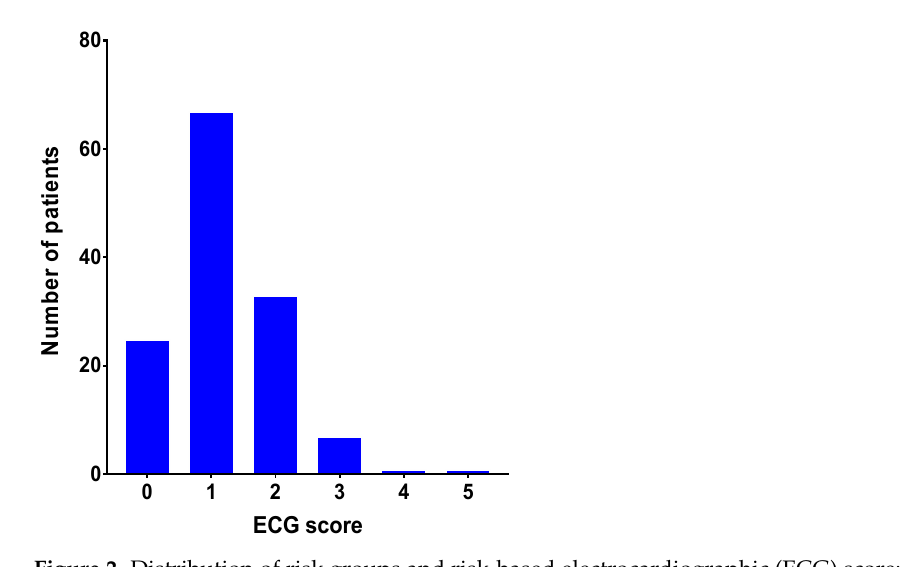
Figure 2. Distribution of risk groups and risk-based electrocardiographic (ECG) score: 19% of the patients (total n = 25) had an ECG score of 0 points, 50% ( n = 67) 1 point, 25% ( n = 33) 2 points, 5% ( n = 7) 3 points and 0.7% ( n = 1) 4 or 5 points respectively.